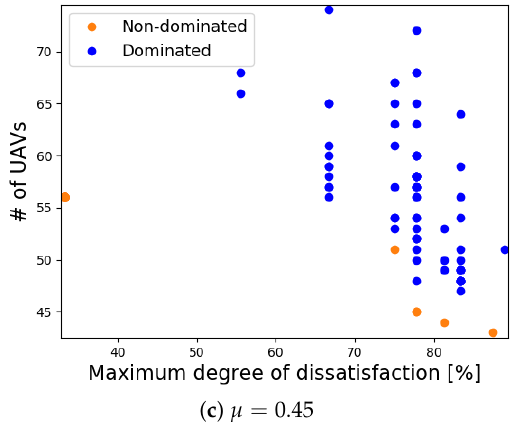
Figure 7. Trade-off between the number of UAVs and the degree of dissatisfaction of the GNs.